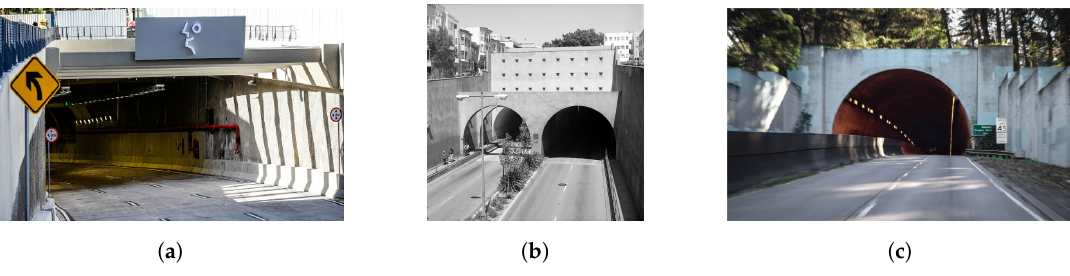
Figure 7. Tunnels which the characterization was performed. ( a ) Rio 450 Years Tunnel [32]; ( b ) Robert C. Levy Tunnel [33]; ( c ) Douglas McArthur Tunnel